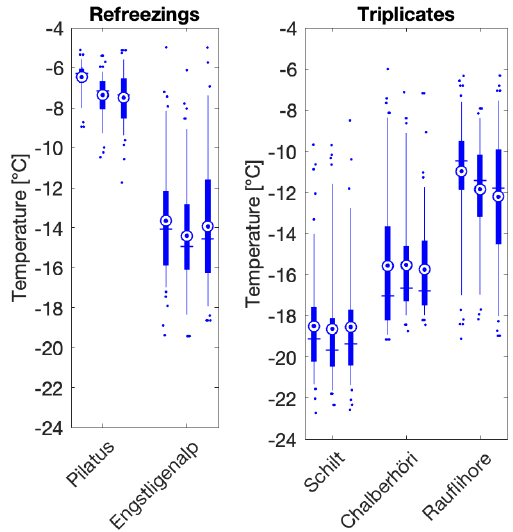
Figure 3. Refreezing and triplicate data at different locations show that the variability is within the instrument error of 0.9 ◦ C. The stan- dard deviation of the refreezings ( ± 0 . 47 ◦ C) is comparable to the standard deviation of the triplicates ( ± 0 . 28 ◦ C). In the boxplots, the blue vertical line shows the median and is equal to T 50 . The mean is shown as a blue circle with a concentric dot and the box ranges from the 25th to the 75th percentiles. The whiskers extend from the 5th to the 95th